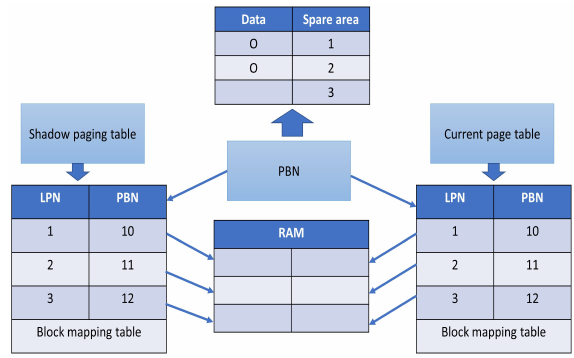
Figure 4. Architecture of our proposed scheme.